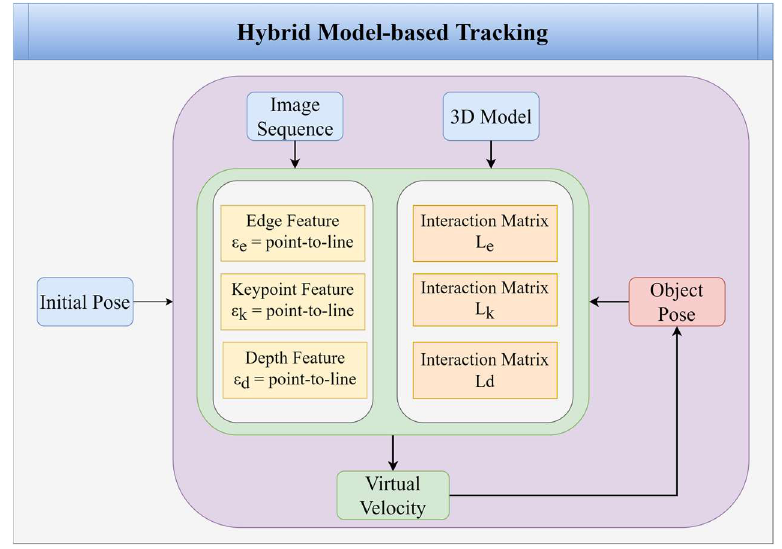
Figure 7. Display of the three features for tracking. ( a ) The edge features. ( b ) The keypoint features. ( c ) The depth features.